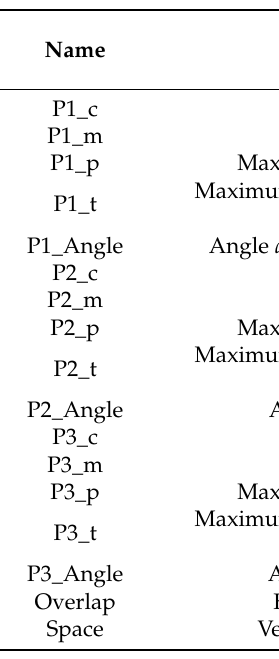
Table 1. Ranges of each variable in the parametric